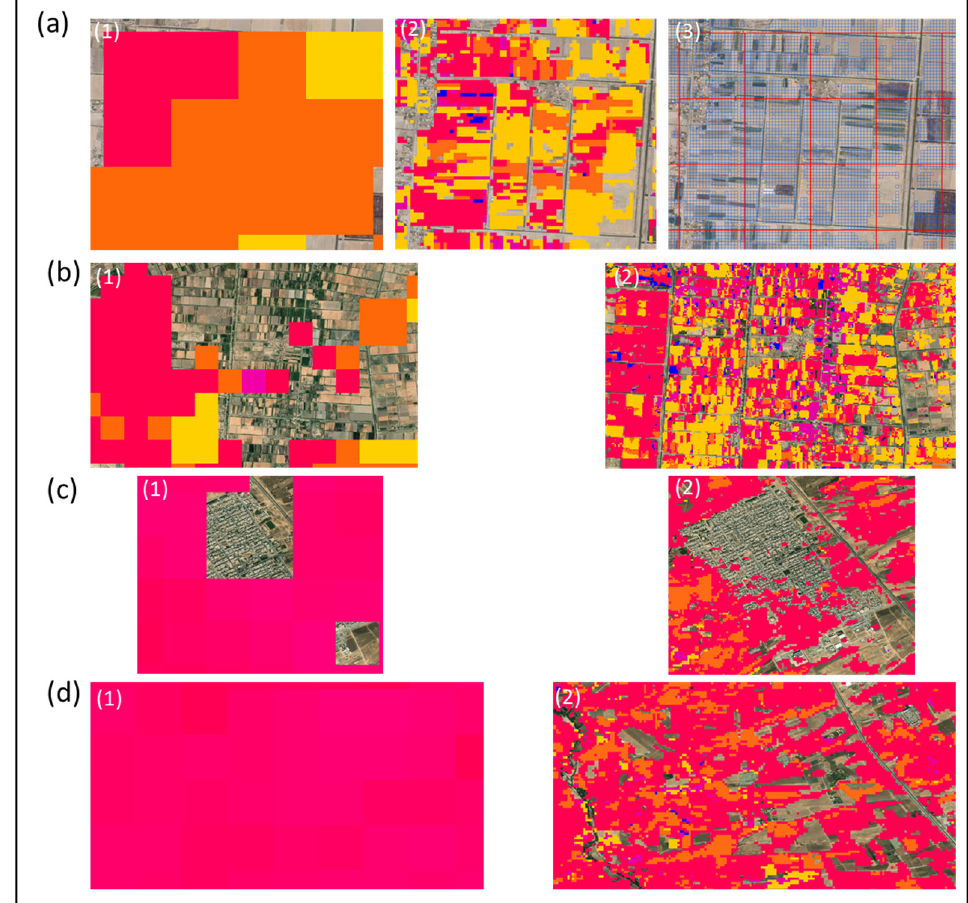
Figure 8. The difference between LSP parameters obtained from MODIS-500 m (MCD12Q2) [94] and our Landsat-30 m estimated in the year 2006. ( a1 ) MODIS-500 m green-up, ( a2 ) Landsat-30 m SOS, ( a3 ) different in spatial resolution and spatial coverage between the two datasets, ( b1 ) Large area in MODIS-500 m were left without LSP estimates, ( b2 ) Landsat-30 m provided LSP estimates in the same areas, ( c1 ) MODIS-500 m inaccurately estimated LSP parameters in an urban area, ( c2 ) Landsat-30 m accurately masked out urban area, ( d1 ) MODIS-500 m estimated LSP regardless of being planted or not, ( d2 ) Landsat-30 m able to highlight cropland fallows. Note that the figures in each pair are mapped in the same area.